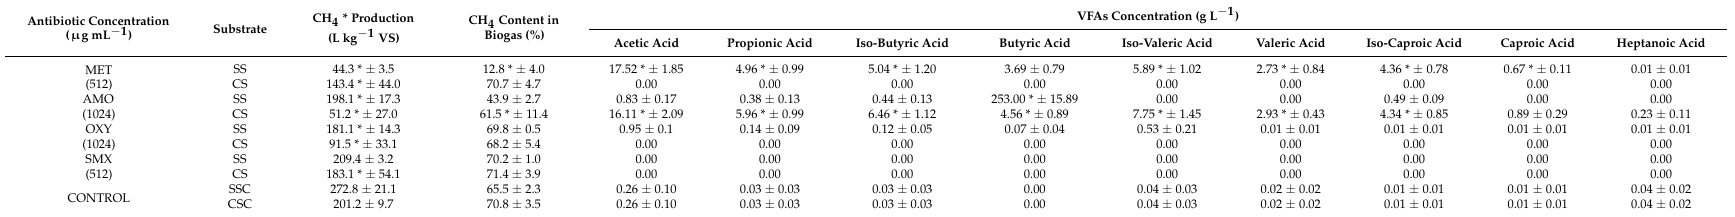
Table 2. The results of methane fermentation in the process reactors with antimicrobial addition and control